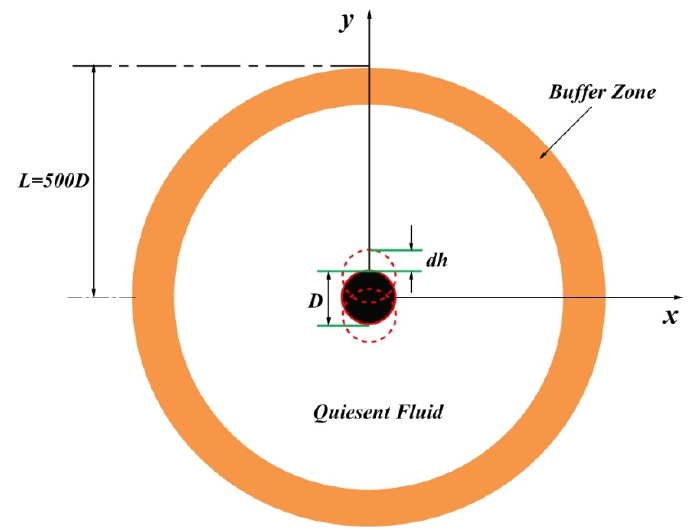
Figure 4. Dipole sound by a vertically oscillating circular cylinder [27].